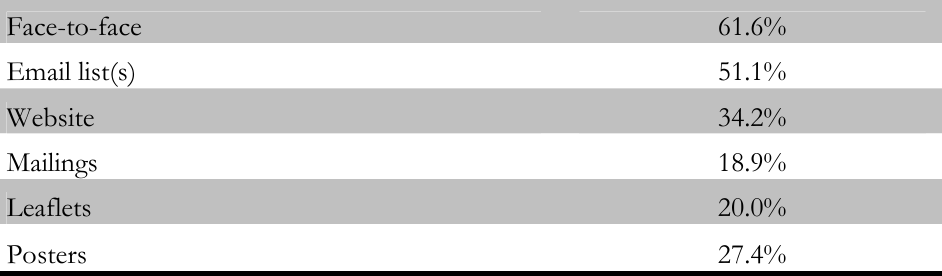
Table 5. Mobilized through political/voluntary